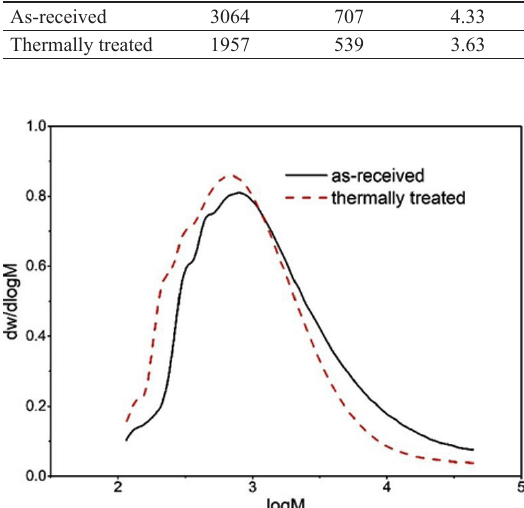
Figure 2. As-received and thermally treated kraft lignin overlaid molecular weight distributions from GPC measurements.